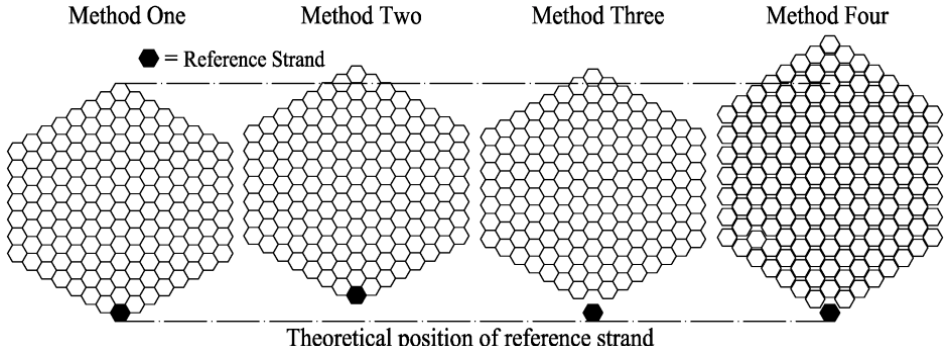
Figure 13. Various control methods of the inter-strand distance.